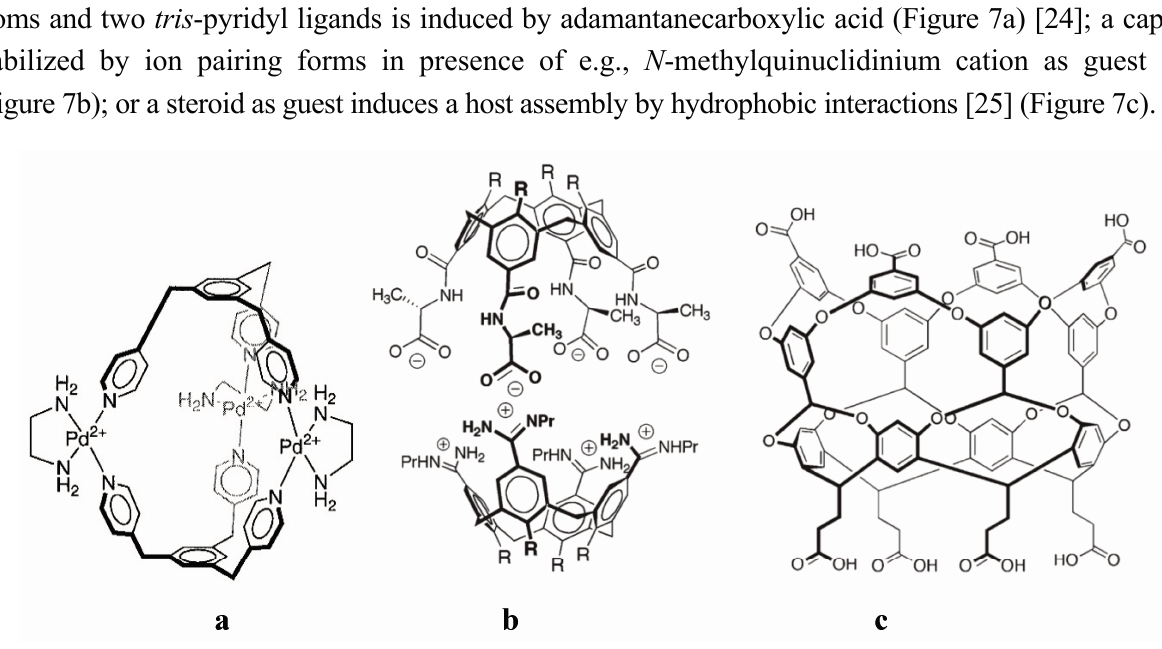
Figure 7. Self-assembly of predesigned host parts to form capsules, ( a ) with adamantanecarboxylic acid as guest [24]; ( b ) by ion pairing, with e.g., N -methylquinuclidinium cation as guest [22]; ( c ) a lipophilic host which self-assembles in presence of a long steroid by hydrophobic interactions